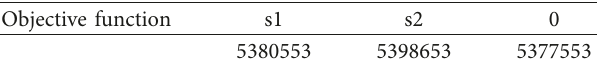
Table 13: Response of the objective function under different